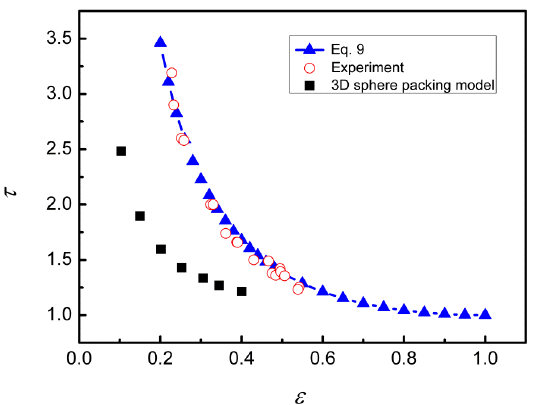
Figure 3. The tortuosity for different porosities. The open circle symbols denote experiment results [15,19–27], line + solid triangle symbols denote the results calculated by Equation (9), solid square symbols denote the results calculated by the 3D sphere packing model [17].